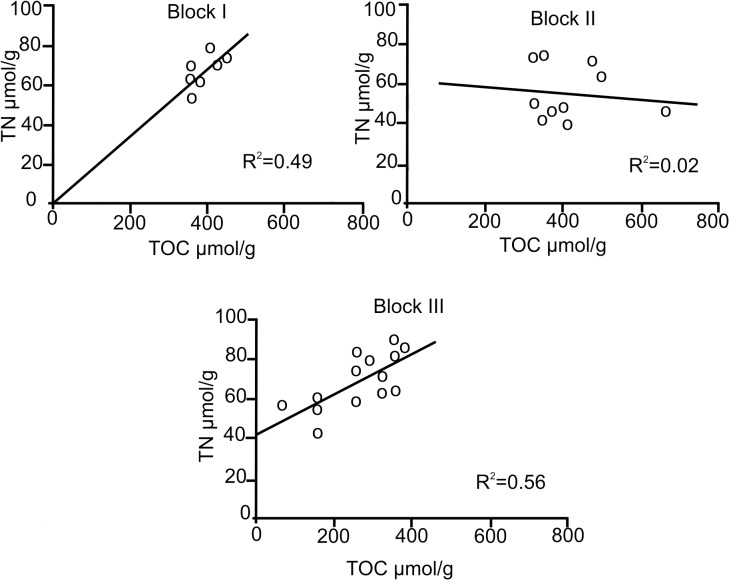
TOC:TN ratios.Correlations of the TOC:TN ratios of each Block examined on the NW slope of Cuba, Southern Florida Straits.